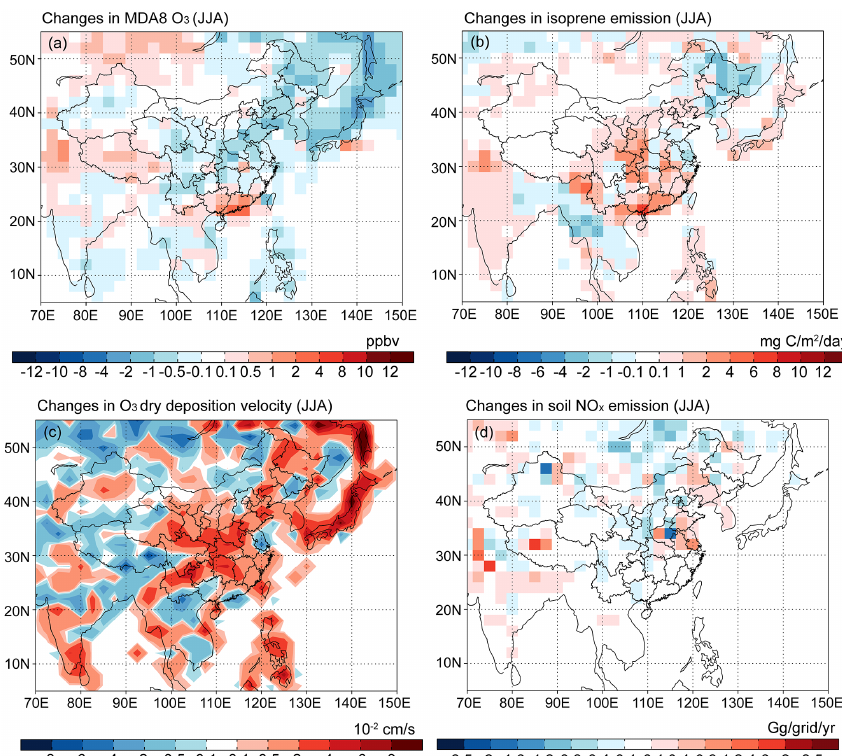
Figure 2. Changes in summertime (JJA) (a) surface maximum daily 8-h average ozone concentration (MDA8 O 3 ) ; (b) isoprene emis- sion; (c) ozone dry deposition velocity; and (d) soil NO x emission, driven by 1980–2010 changes in land cover and land use alone ([CTRL] − [SIM_LCLU]). Values are differences between the 5-year averages over the present-day and historical